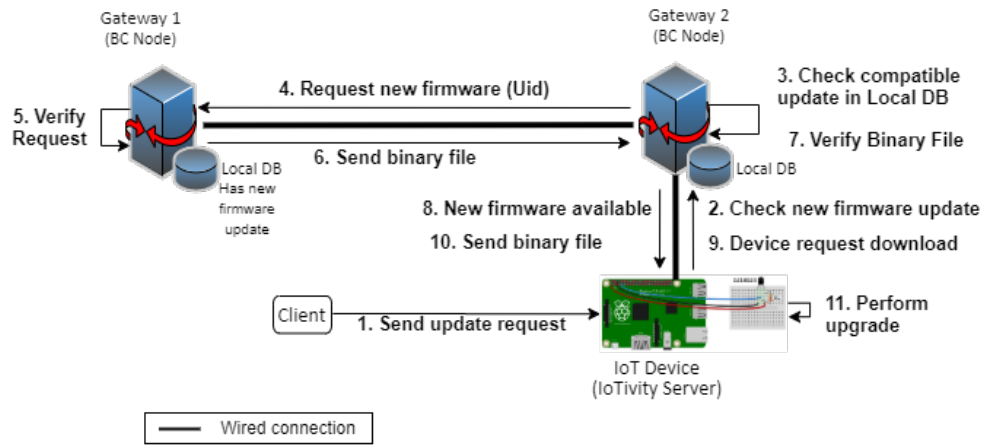
Figure 9. Implementation of a peer-to-peer firmware update distribution.